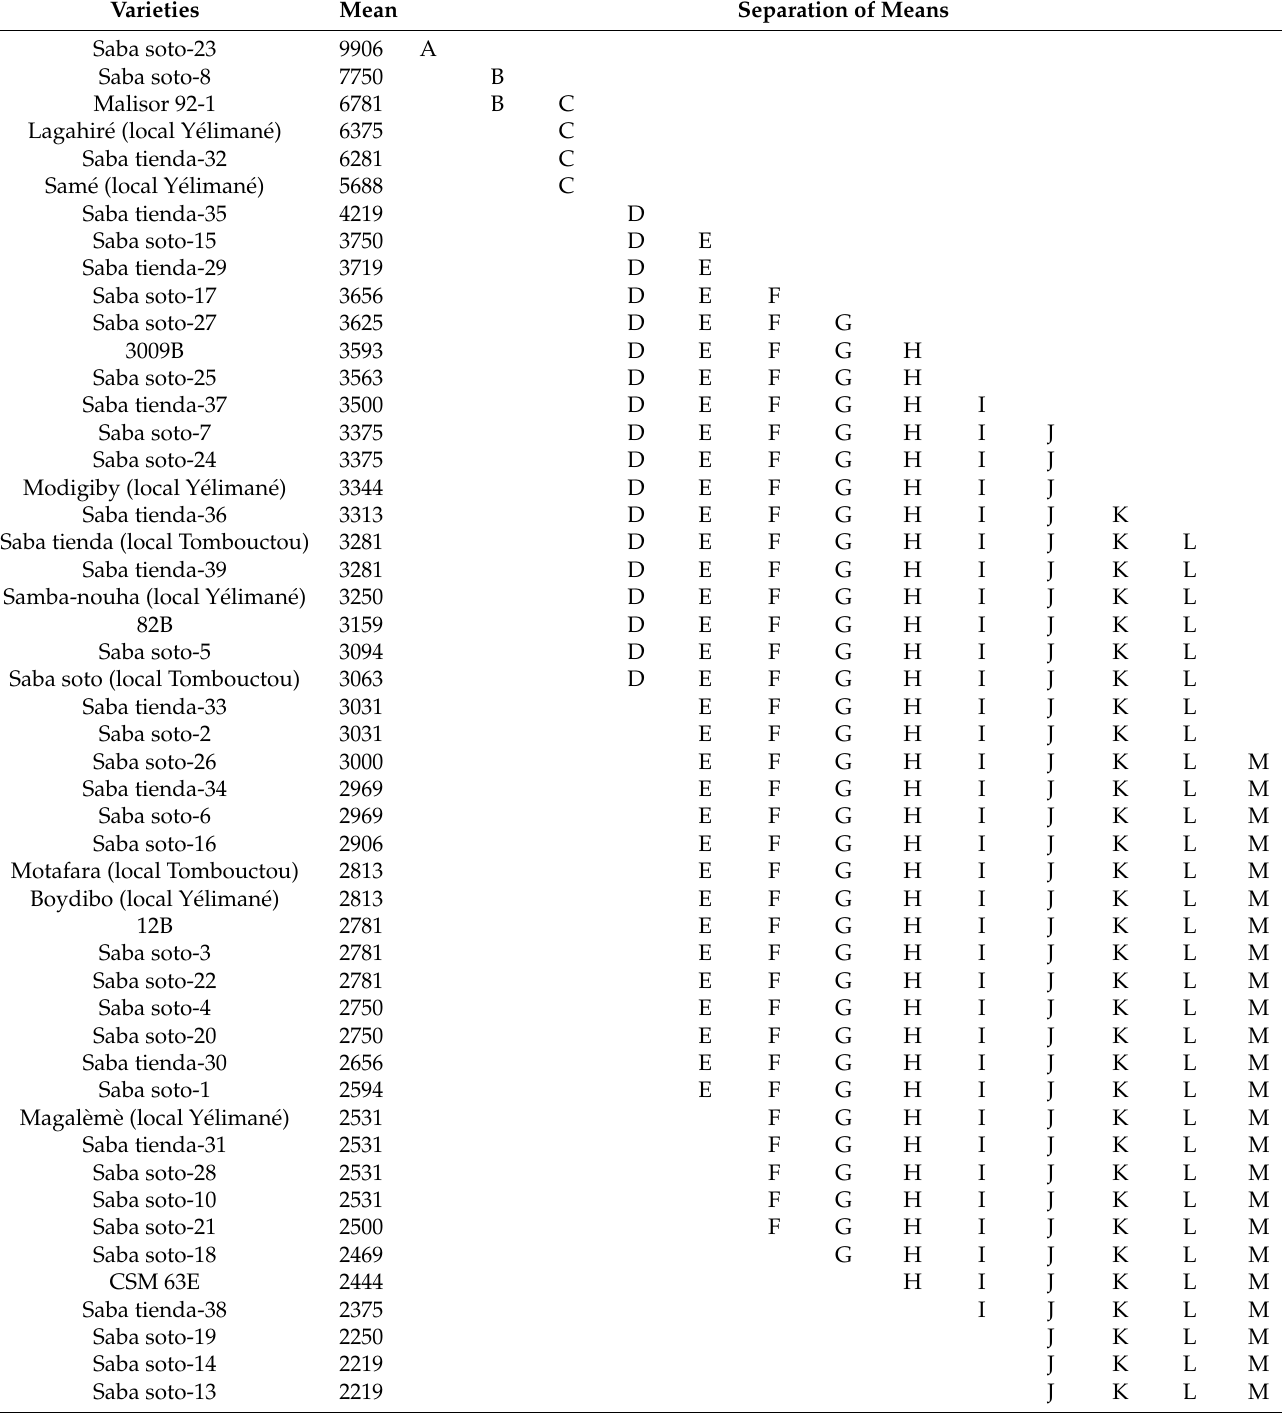
Table 3. Average sorghum straw yield (kg ha − 1 ) across sites of flood recession farming for 54 varieties tested in Yaguine, Gory, and Foungou in the 2013/2014 cropping season. Varieties with letters that do not overlap (A to M) are significantly